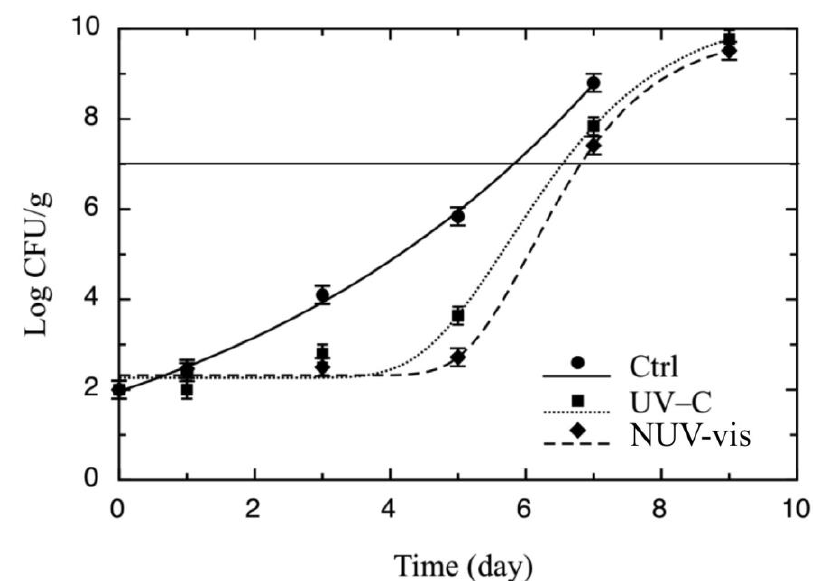
Figure 3. Evolution of yeasts during the shelf life test in ricotta cheese inoculated with P. fluorescens (DSM 50090) (10 3 CFU/mL), treated with UV-C and NUV–vis light, at one light dose per technology, with respective control samples (Ctrl). A total of 36 samples were treated once, on the same day, which corresponded to time zero of the storage period, and then analyzed for 9 days. The continuous line represents the best fitting of Equation (1) to the experimental counts of yeasts. The horizontal line represents the threshold for microbiological acceptability, set to 7 Log CFU/g.